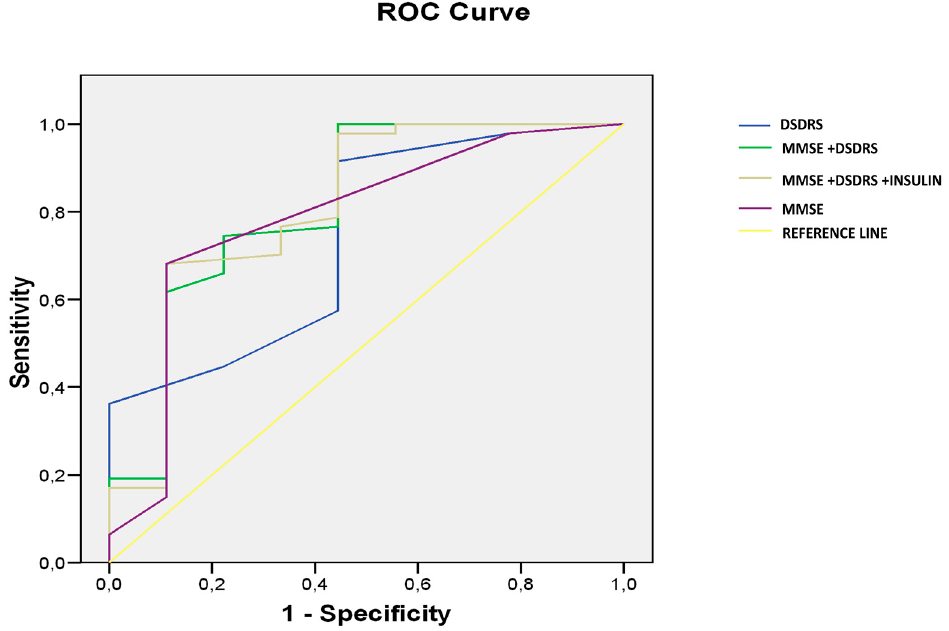
Figure 2. The ROC Curve for the MMSE and DSDRS as screening tools of cognitive impairment. MMSE: Mini-Mental State Examination, DSDRS: diabetes specific dementia risk score.